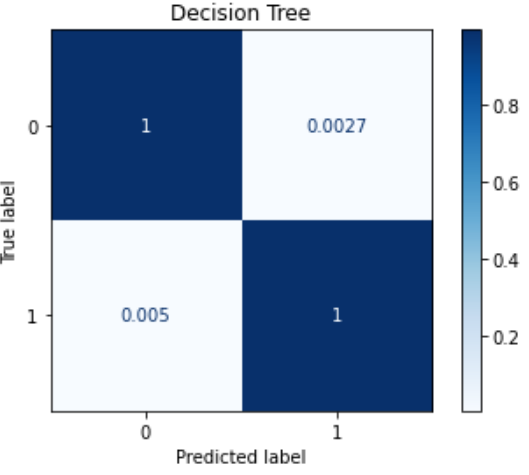
Figure 4. Confusion Matrix Plotfor Testing with IoT-ID Dataset.